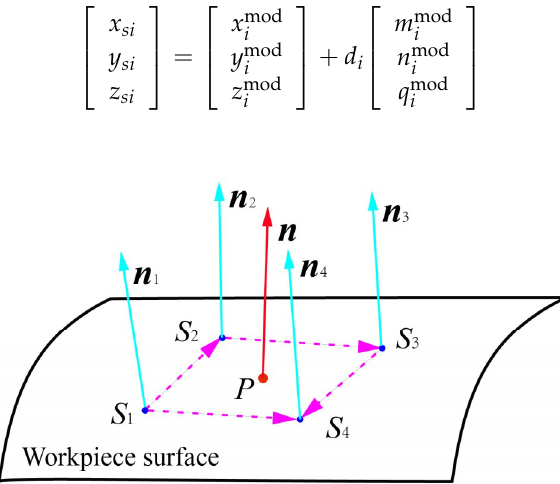
Figure 5. The surface normal measurement.